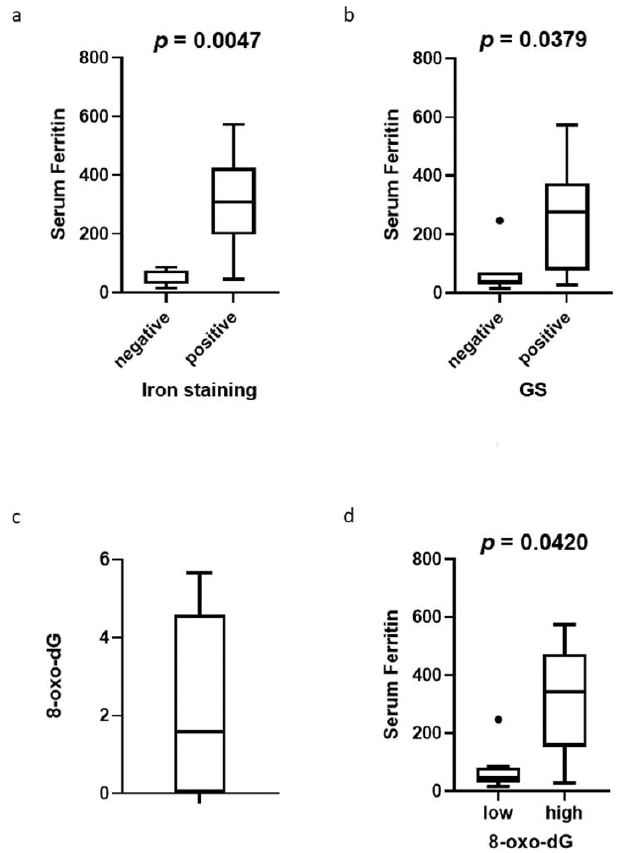
Figure 2. The relationships between immunohistochemical staining and serum ferritin levels. ( a ) Serum ferritin levels in iron staining-negative and -positive cases. ( b ) Serum ferritin levels in GS-negative and -positive cases. ( c ) 8-oxo-dG scores of non-cancerous areas in the liver in all NAFLD-HCC cases. ( d ) Serum ferritin levels compared between 8-oxo-dG low cases and high